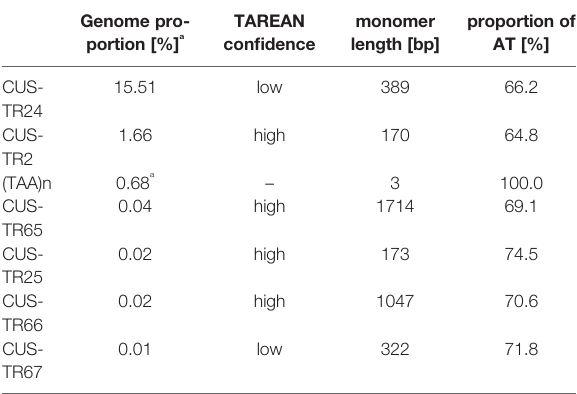
TABLE 2 | Characteristics of satellite DNA families identi fi ed in C. europaea